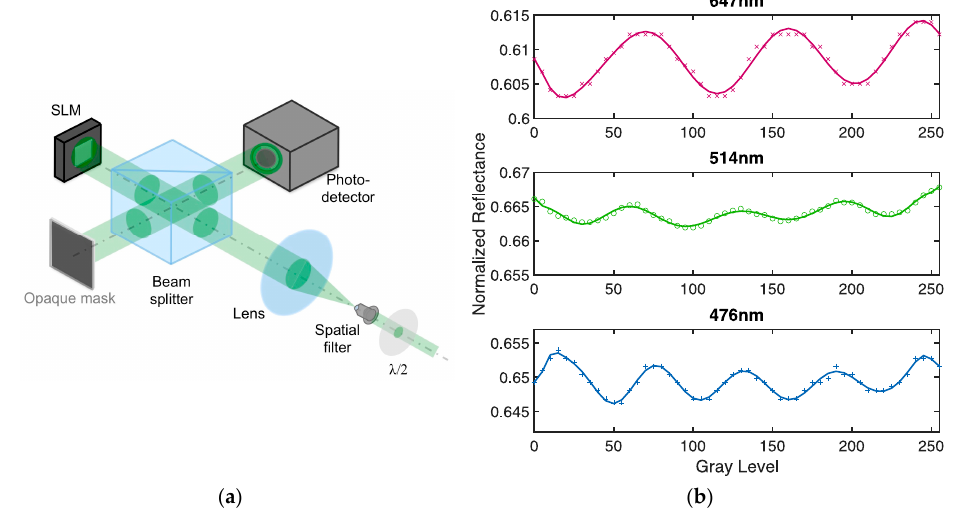
Figure 5. ( a ) Scheme of the experimental setup. ( b ) Reflectance modulation versus varying grey level addressed to the SLM.